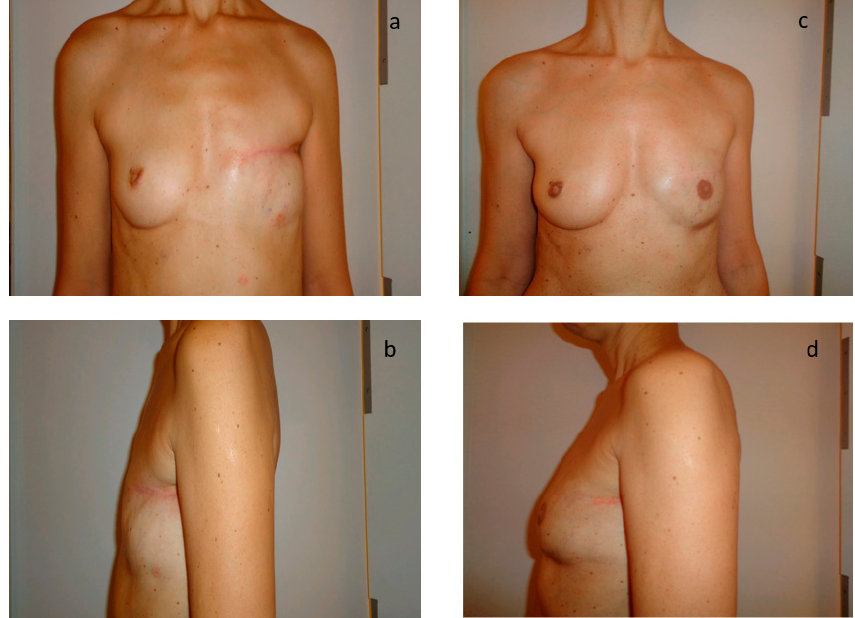
Figure 1. Aesthetic result after breast reconstruction by exclusive lipofilling in patient with A bra size. ( a , b ) Results after total mastectomy; ( c , d ) Results after 3 sessions of reconstruction by exclusive lipofilling.